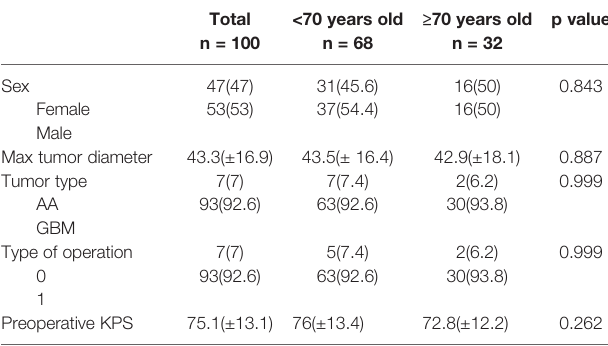
TABLE 2 | Clinical and pathological features of patients strati fi ed for age (<70 years old vs. ≥ 70 years